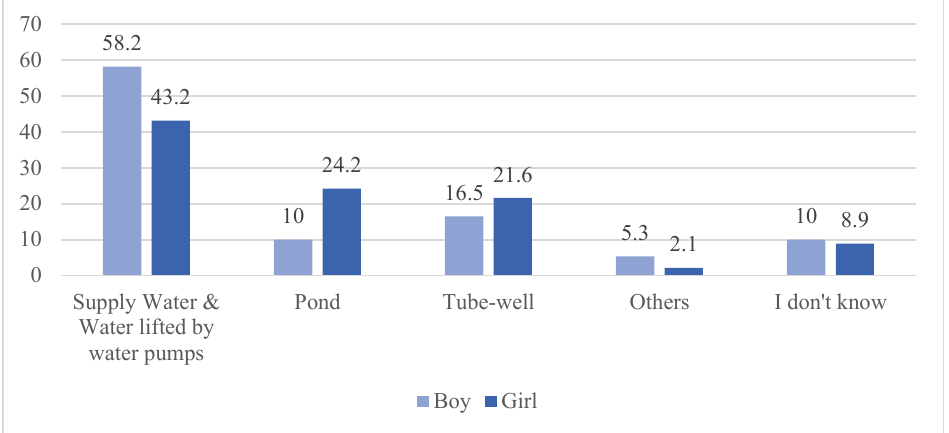
Source: own calculation,